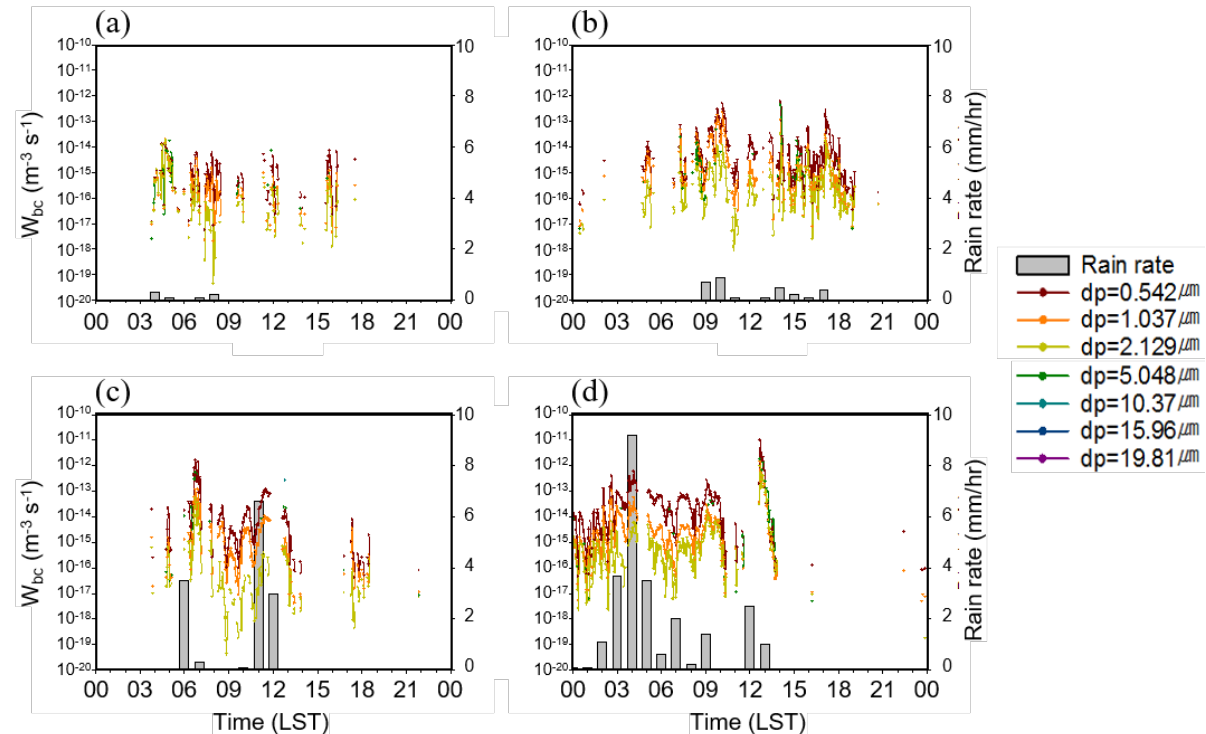
Figure 9. Time series of the below-cloud scavenging rate and rain rate for several aerosol diameters from ( a – d ) (cases 1 to